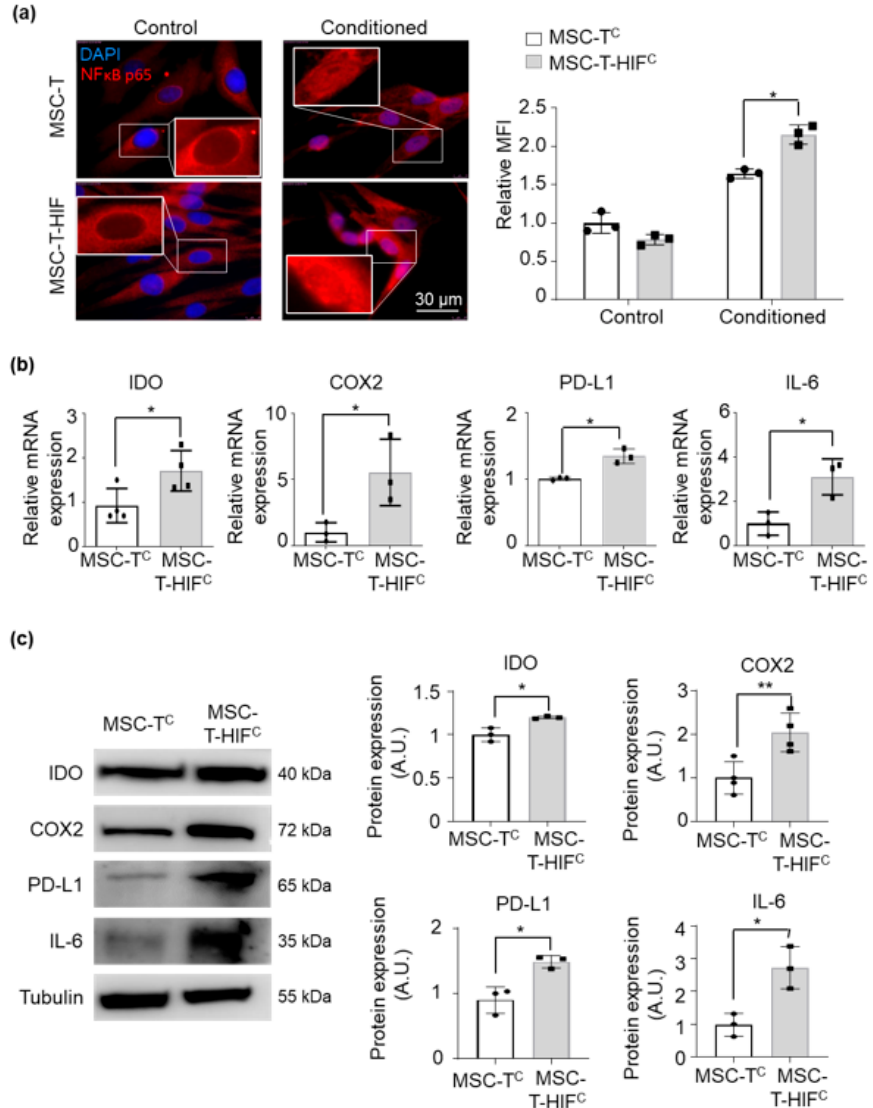
Figure 3. HIF overexpression strengthens signaling through the NF- κ B pathway and consequently the expression of immunosuppressive cytokines. ( a ) Immunolocalization of p65 in MSC-T, MSC-Tc, MSC-T with an HIF-1 α -GFP lentiviral vector (MSC-T-HIF) and conditioned MSC-T-HIF (MSC-T-HIFc). Red: p65, blue: DAPI. Scale bar: 30 μ m. Mean of fluorescence intensity was measured per nucleus and values were normalized to those of MSC-T cells (each point represents the mean of 50 nuclei). Graphs represent mean ± SD of three independent experiments. Sidak’s multiple comparisons test was used for statistics. ( b ) IL-6 , IDO , COX2 and PD-L1 expression levels quantified by RT-qPCR in MSC-Tc and MSC-T-HIFc. Expression level of the target gene in each sample was normalized to GAPDH expression. Graphs represent mean ± SD of fold change of three independent experiments. Paired t -test was used for statistics. ( c ) Representative Western blots of IL-6, IDO, COX2 and PD-L1 proteins. Expression levels were quantified by densitometry relative to MSC-Tc. α -tubulin was used as a protein loading control. Bars represent mean ± SD of three independent experiments. Paired t -test was used for statistics. * p < 0.05, ** p <